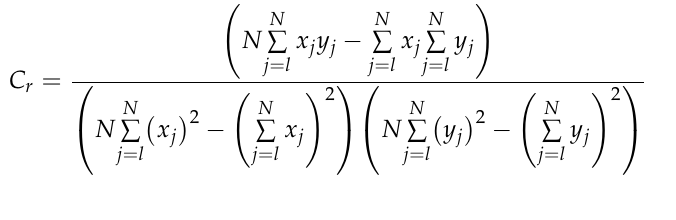
Figure 9. Histogram analysis. ( a , e,i , m ) are the original images, ( b , f , j , n ) are the histograms of the original images, ( c , g , k , o ) are the encrypted images, ( d , h , l , p ) are the histograms of the encrypted images.